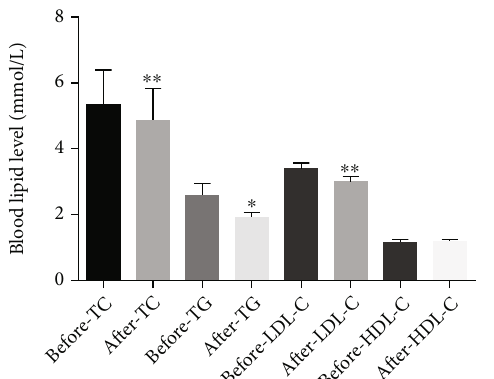
Figure 3: Changes of blood lipids after liraglutide treatment. The levels of total cholesterol (TC), triglyceride (TG), low-density lipoprotein cholesterol (LDL-C), and high-density lipoprotein cholesterol (HDL-C) were measured by automatic biochemical analyzer ( ∗ p < 0 : 05 and ∗∗ p < 0 : 01 ).